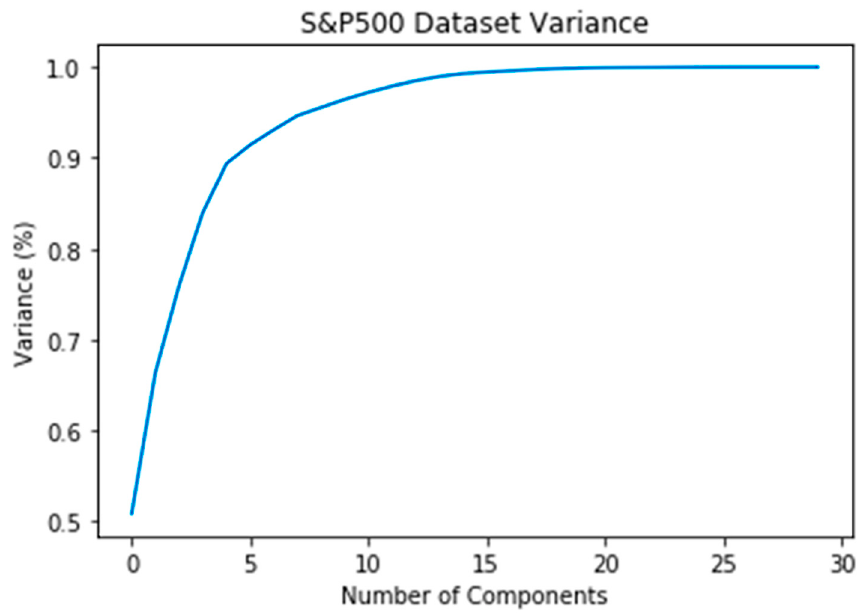
Figure 5. Variance captured by principal components.